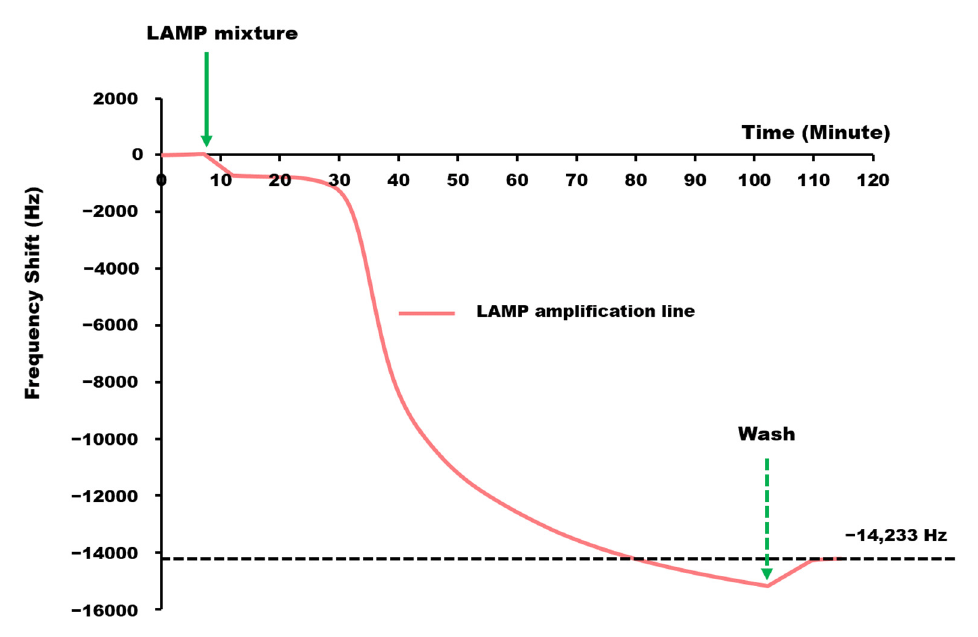
Figure 2. Real-time QCM resonant frequency shift with irreversible signal of LAMP products adsorbed on QCM electrode.